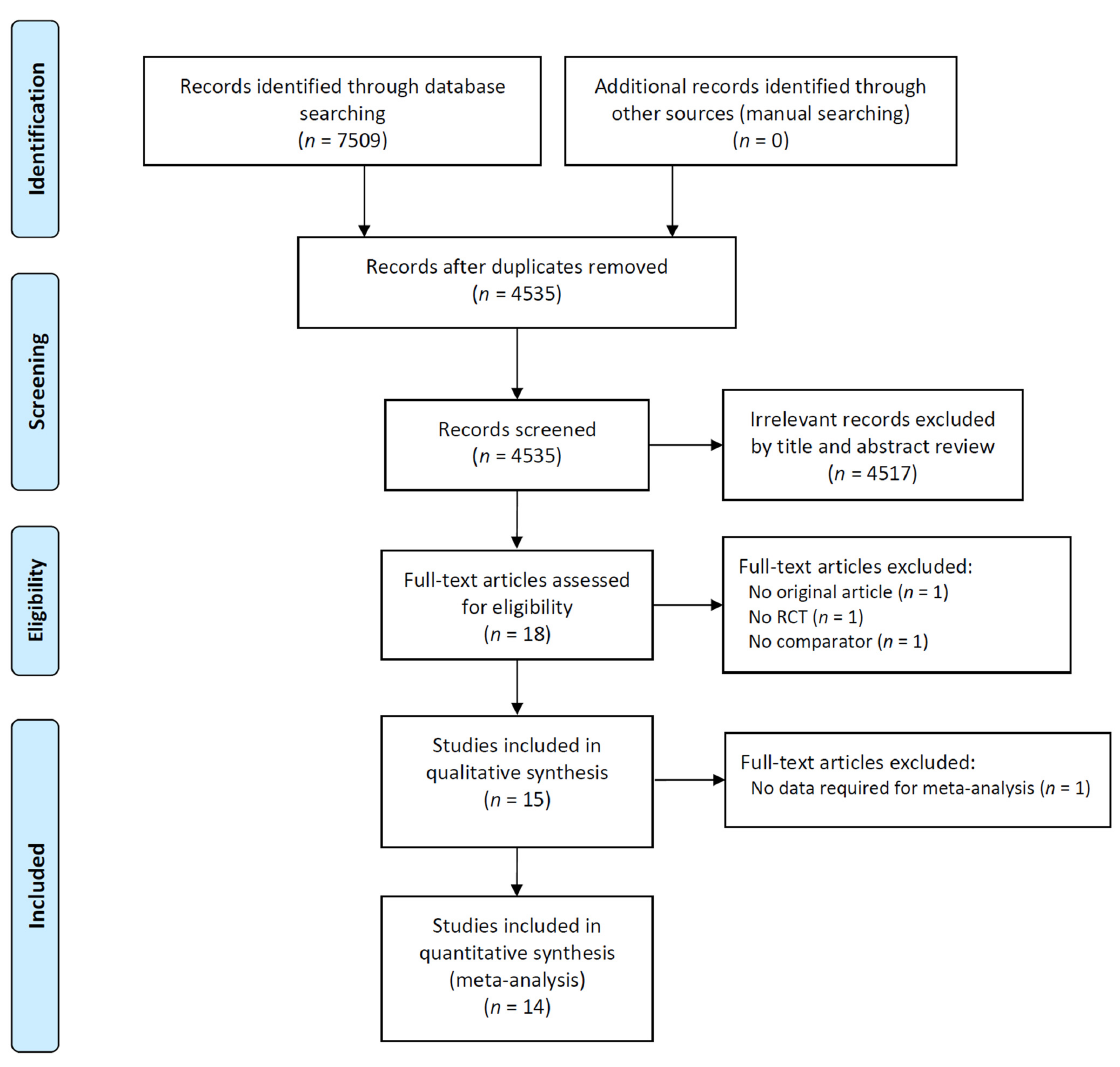
Figure 1. Study flow diagram.